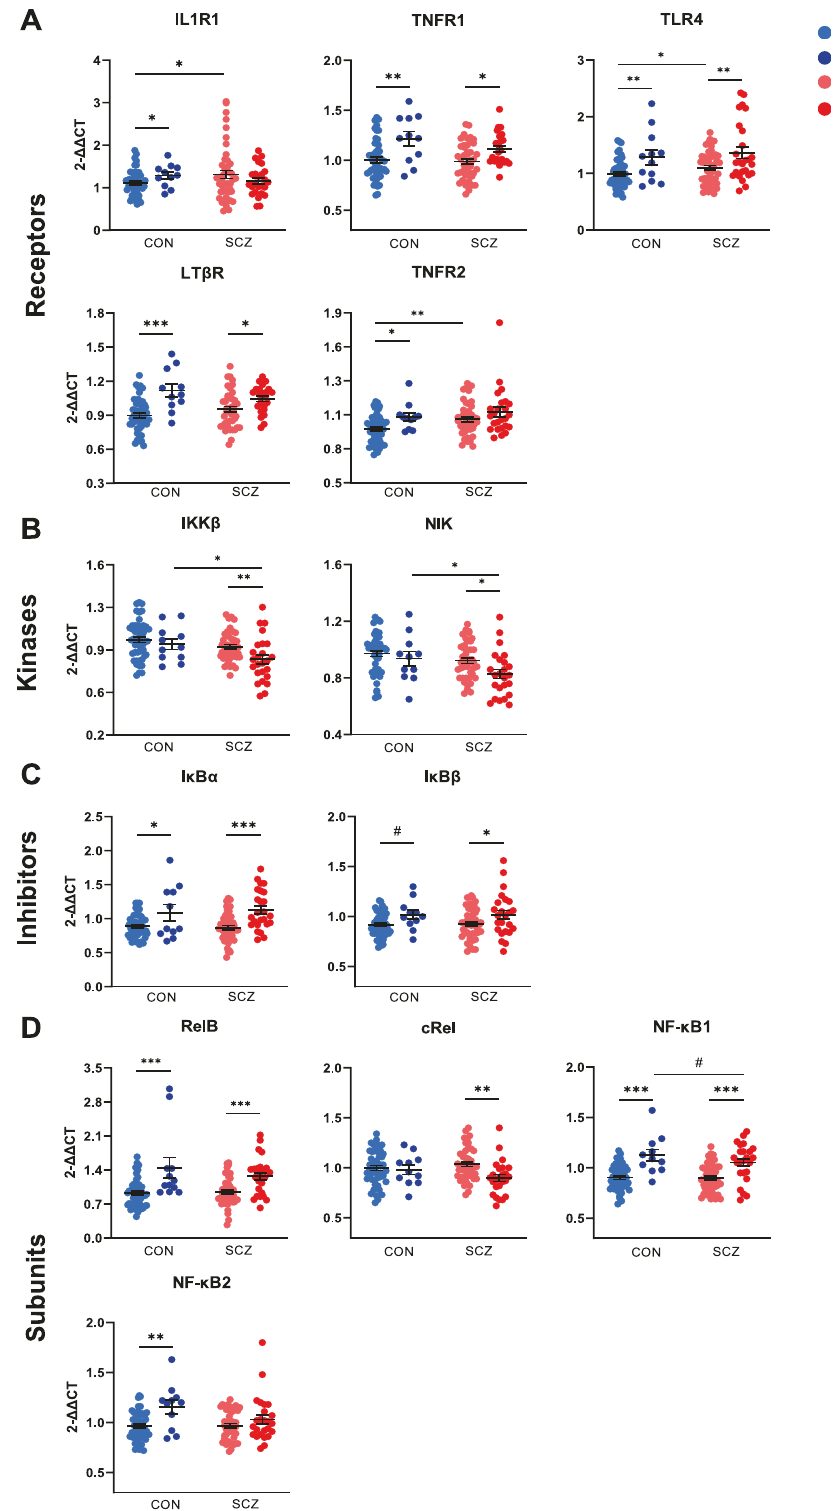
Fig. 4 Peripheral blood leukocyte gene expression of the NF- κ B pathway in healthy controls and people with schizophrenia strati fi ed by in fl ammatory biotype. A NF- κ B-activating receptor mRNAs, B NF- κ B-inducing kinase mRNAs, C NF- κ B inhibitor mRNAs, D NF- κ B subunit- encoding mRNAs. Lines and whiskers in graphs represent mean + standard error. *** p < 0.001, ** p < 0.01, * p < 0.05, # p =